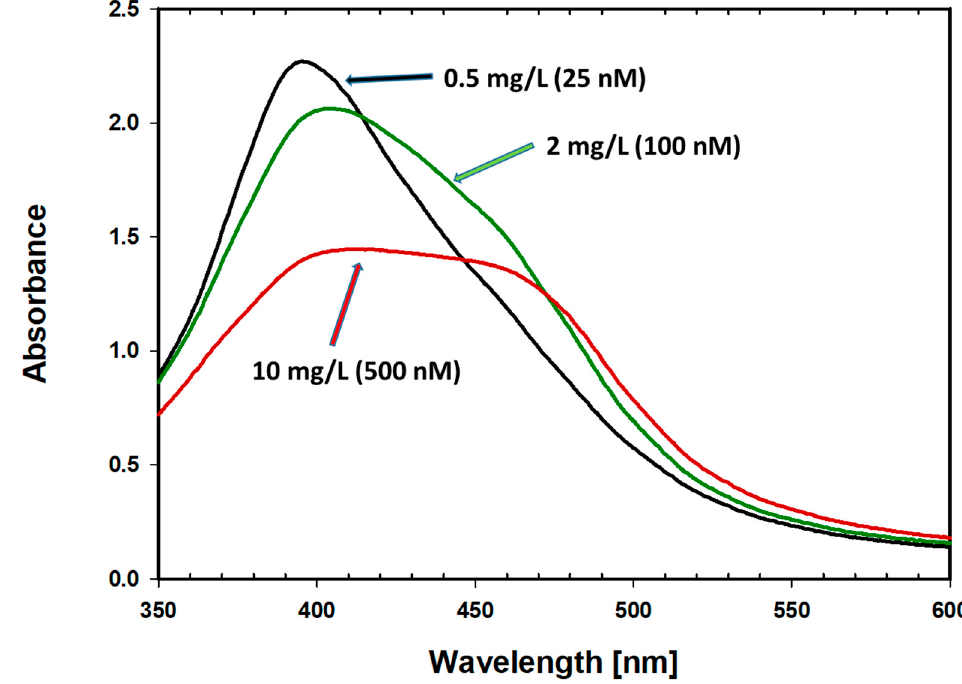
Figure 8. Spectral changes of the nanoparticle aggregates after the addition of different numbers of immunoglobulin free light chains to antibody-coated nanoparticles [10 nM]. The final FLCs concentrations were within a range of 0.5–10 mg/L (25–500 nM).